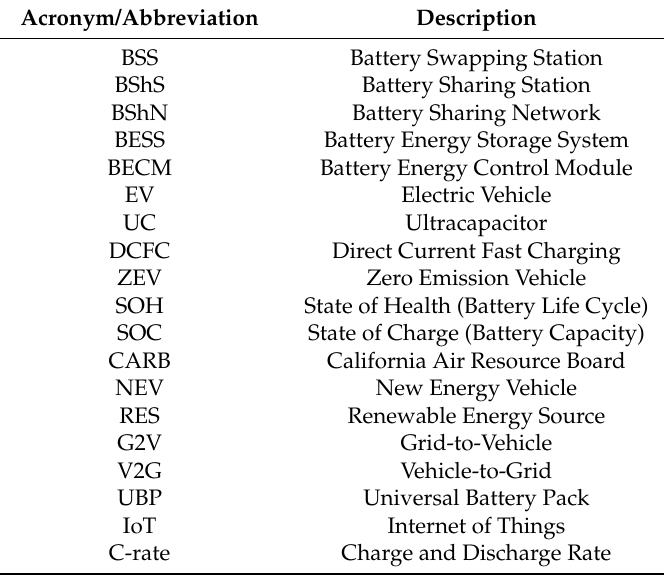
Table 1. Acronyms and abbreviations.